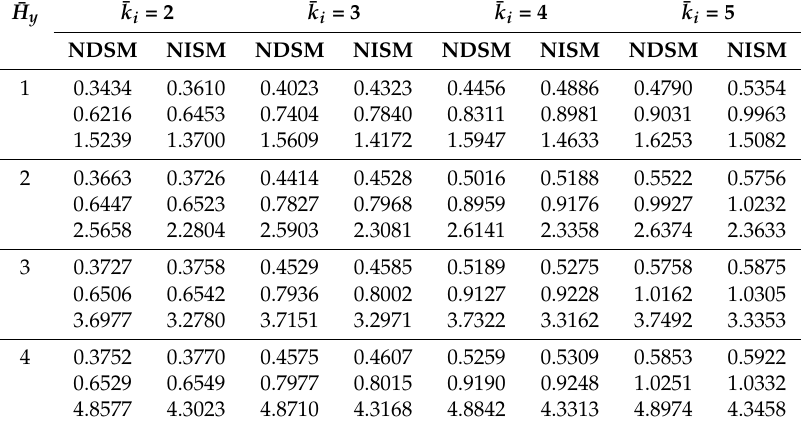
Table 4. A verification between the predicted first three longitudinal frequencies of the magnetically affected nanorod with FIFI ends according to the NDSM and those of the NISM ( l b = 20 nm, N = 3, D 0 = 4 nm, e 0 a = 1 nm).